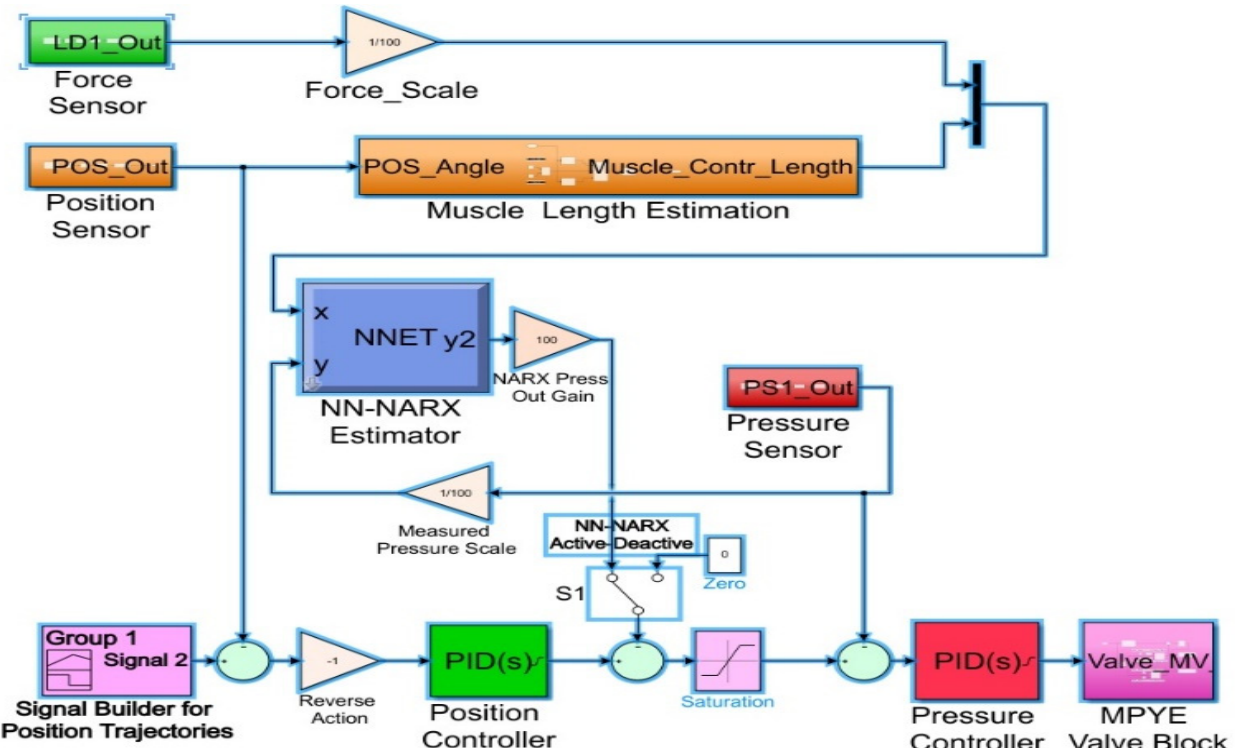
Figure 12. Overall Control System Simulink Block Diagram.